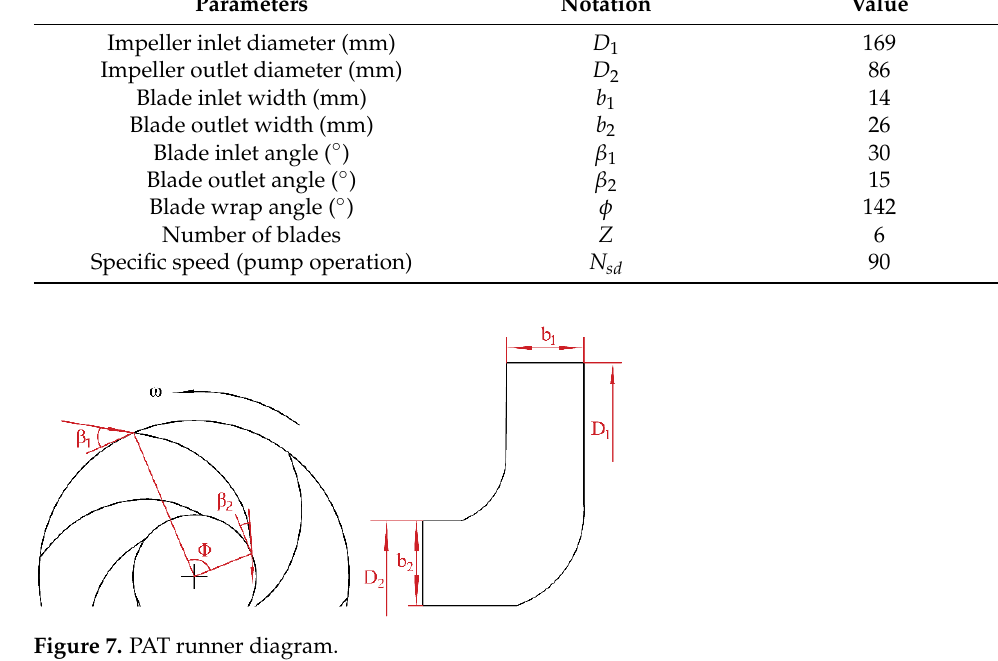
Figure 6. Pictures of the current study’s PAT. Left: front chamber of the impeller; right: back chamber of the impeller. Table 1. Geometric parameters and performance parameter of the PAT.